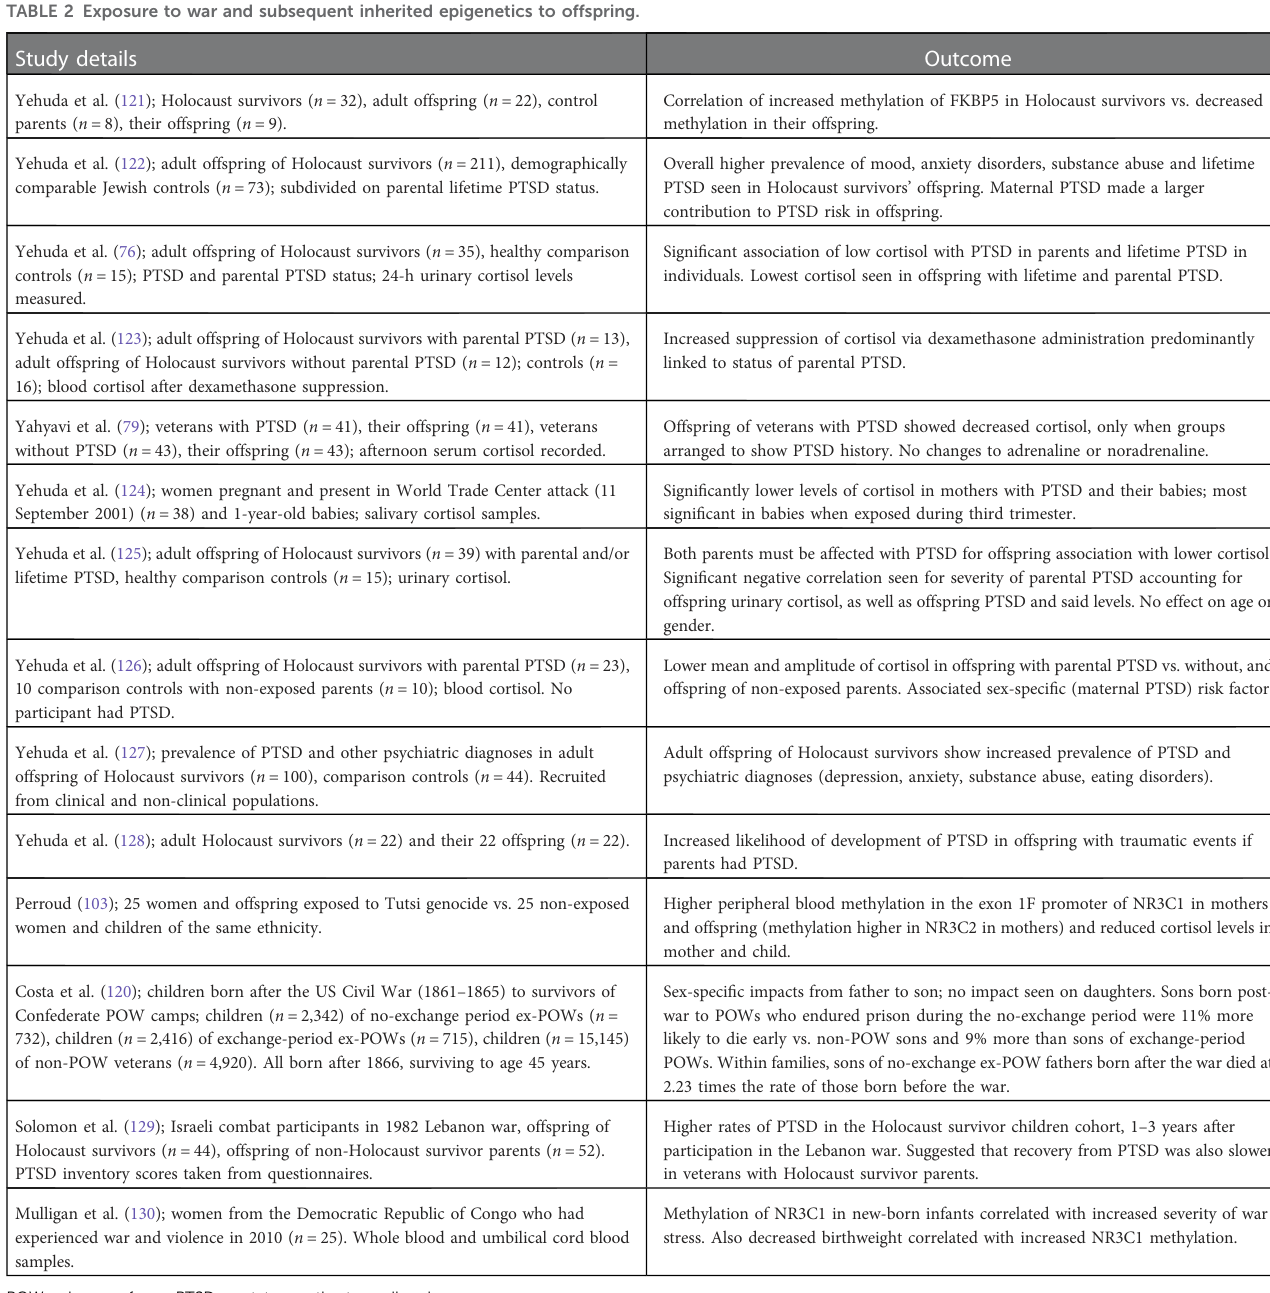
TABLE 2 Exposure to war and subsequent inherited epigenetics to